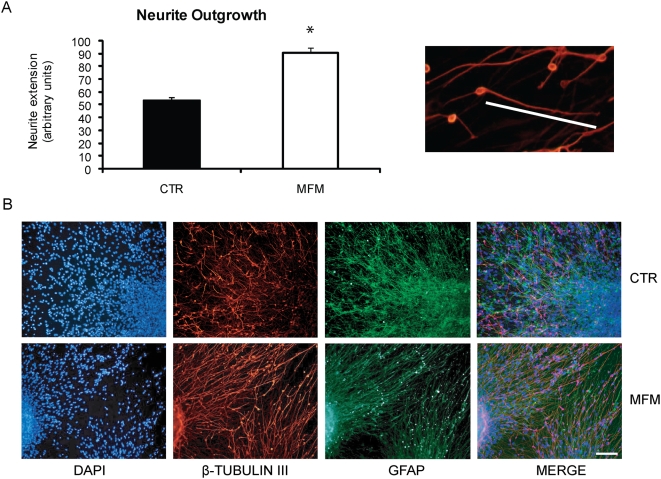
Growth factor removal promotes neurite extension in hNPC.Immunocytochemistry for β-tubulin III showed neurons with longer processes in the MFM group, while the CTR group originated neurons with shorter processes (t-Student-test, p<0.05) (A). Higher magnification images of the differentiated neurons were used to access neurite extension after plating and migration, considering the distances between the cell bodies and the end of the longer processes found (n = 15). Immunolabeling for β-tubulin III+(red) and GFAP+cells (green) for the CTR and MFM after plating and 7 days differentiation. The processes were longer in the MFM group, as well as the radial orientation, that was absent in the CTR group (B). Total nuclei were stained with DAPI (blue). 200× magnification.